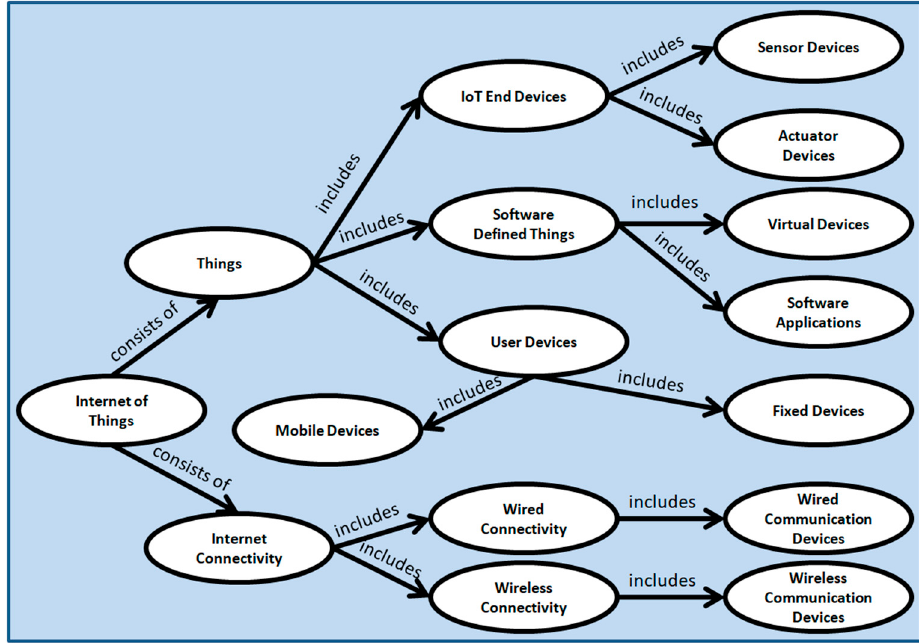
Figure 4. Ontology of IoT visualized as a semantic network.